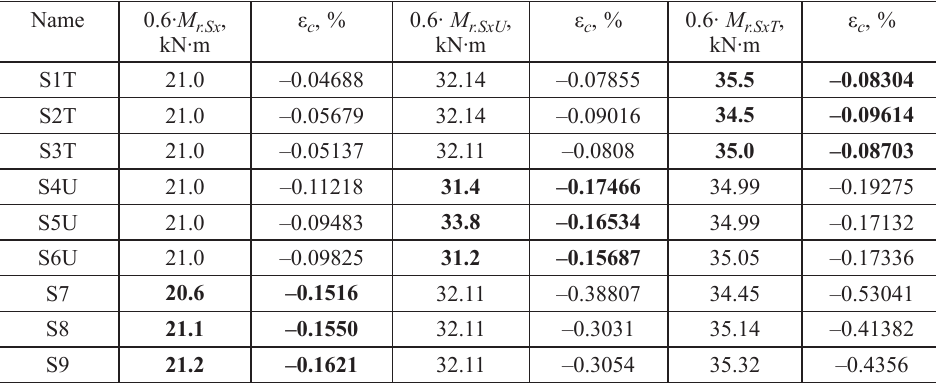
Table 7. Strains of the mostly compressed concrete layer when M = 0.6· M r